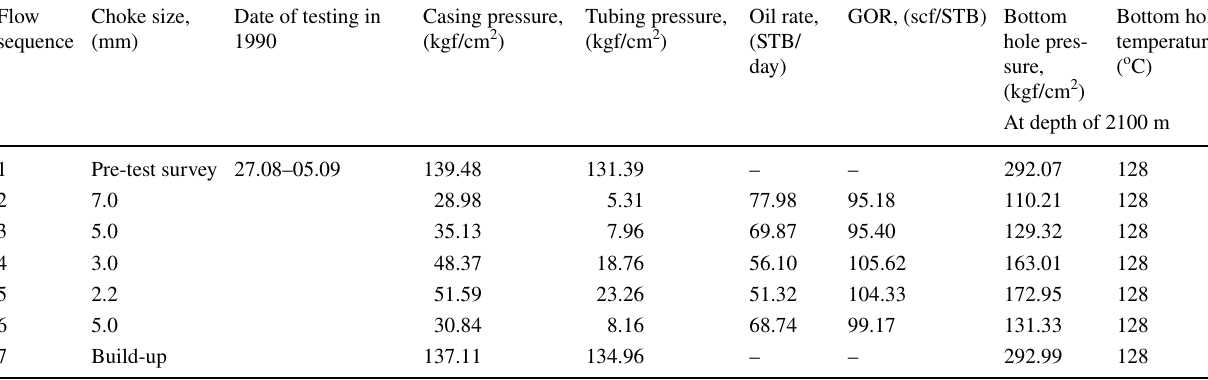
Age of sediments: Lower Maikop. Perforated interval: 2036–2056 Table 14 Production test results of Well # 12 Vorobyevskaya